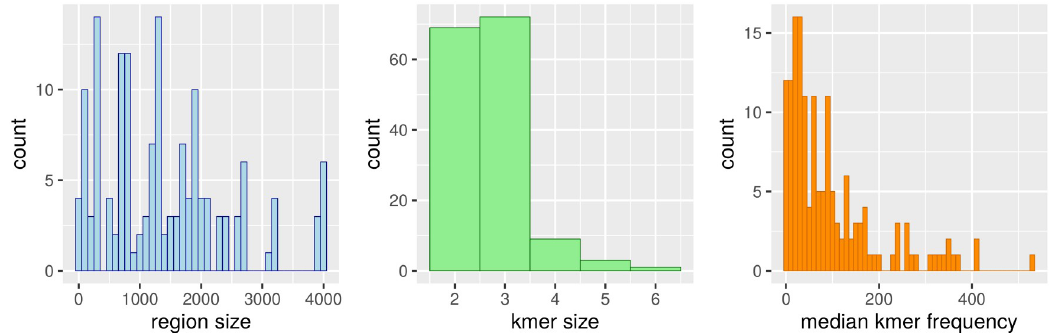
Fig 3. Lengths and frequencies of the variables identifiedin the different species and conditions. The left histogram reports the distribution of k-mer lengths of the most important variables identified in all species and conditions, while the middle histogram reports the distribution of region lengths of these variables. The right histogram reports the median number of occurrences of the identified k-mers in the identified regions in all studied sequences of the different